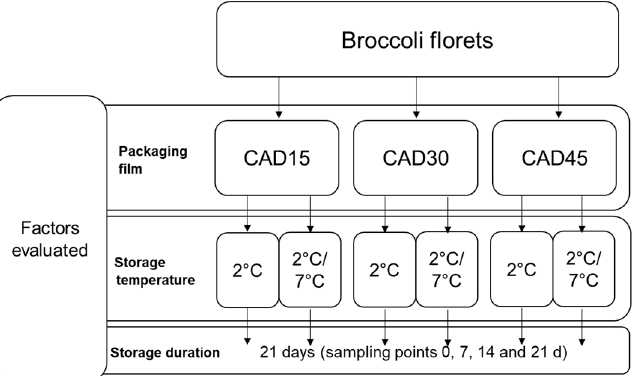
Figure 1. Diagram of experimental design. Packaging film: CAD15, CAD30, and CAD45 refer to the packaging films with different levels of micro-perforation (15 mm, 30 mm, and 45 mm distance between perforations, respectively). Storage temperature: 2 °C) broccoli florets were kept at 2 °C throughout all storage. The 2 °C/7 °C) broccoli florets were kept at 2 °C and transferred to 7 °C two days before sampling.